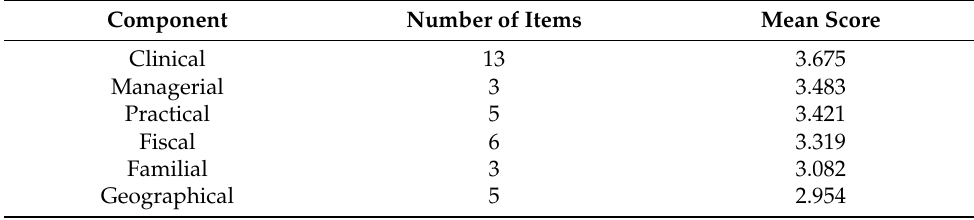
Table 5. Mean score of each nursing student